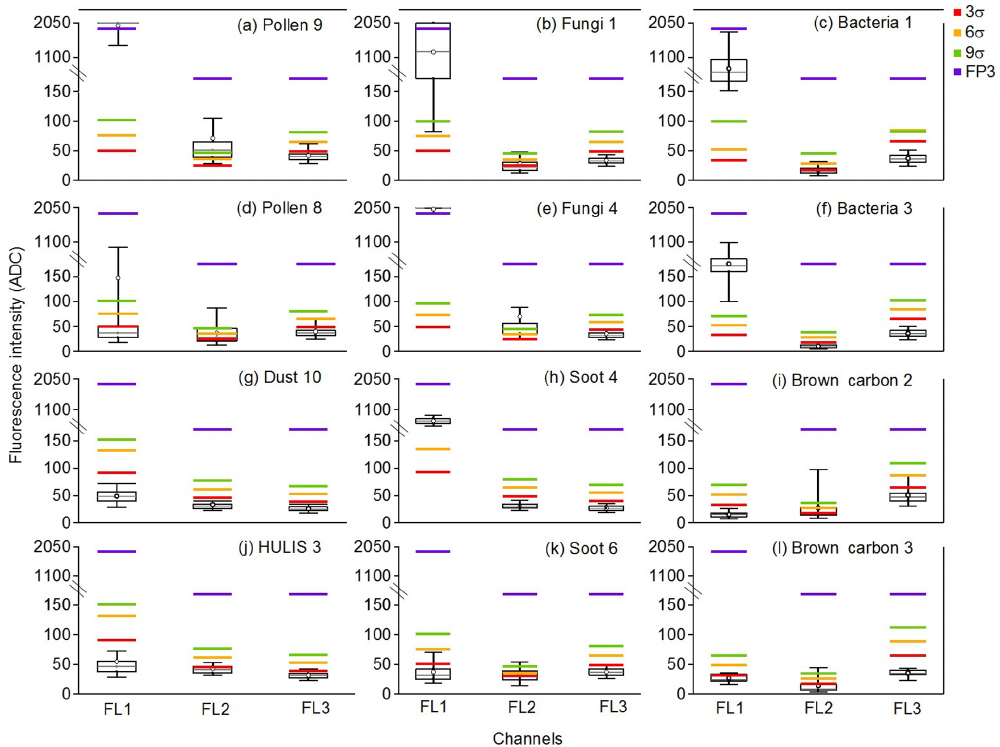
Figure 5. Box whisker plots showing statistical distributions of fluorescence intensity in analog-to-digital counts (ADC) in each channel. Averages are limited to particles in the size range 3.5–4.0µm for pollen, fungal spore, HULIS, and dust samples and in the range 1.0–1.5µm for bacteria, brown carbon, and soot samples. Horizontal bars associated with each box and whisker show four separate threshold